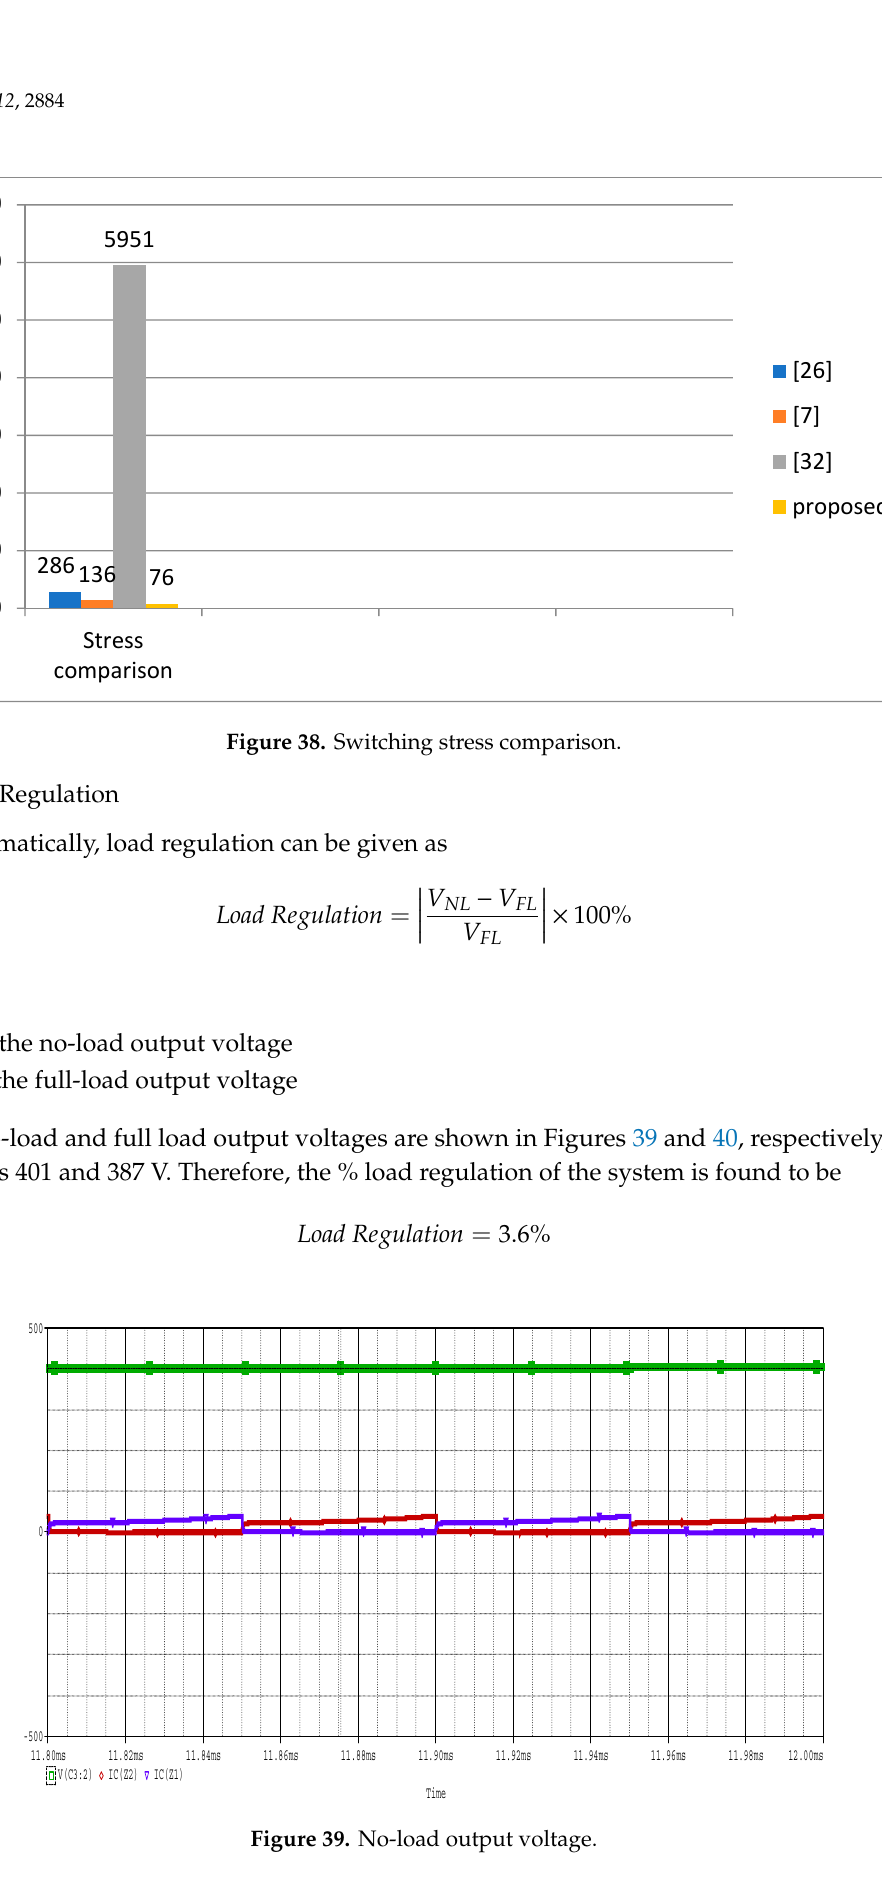
Figure 39. No-load output voltage.